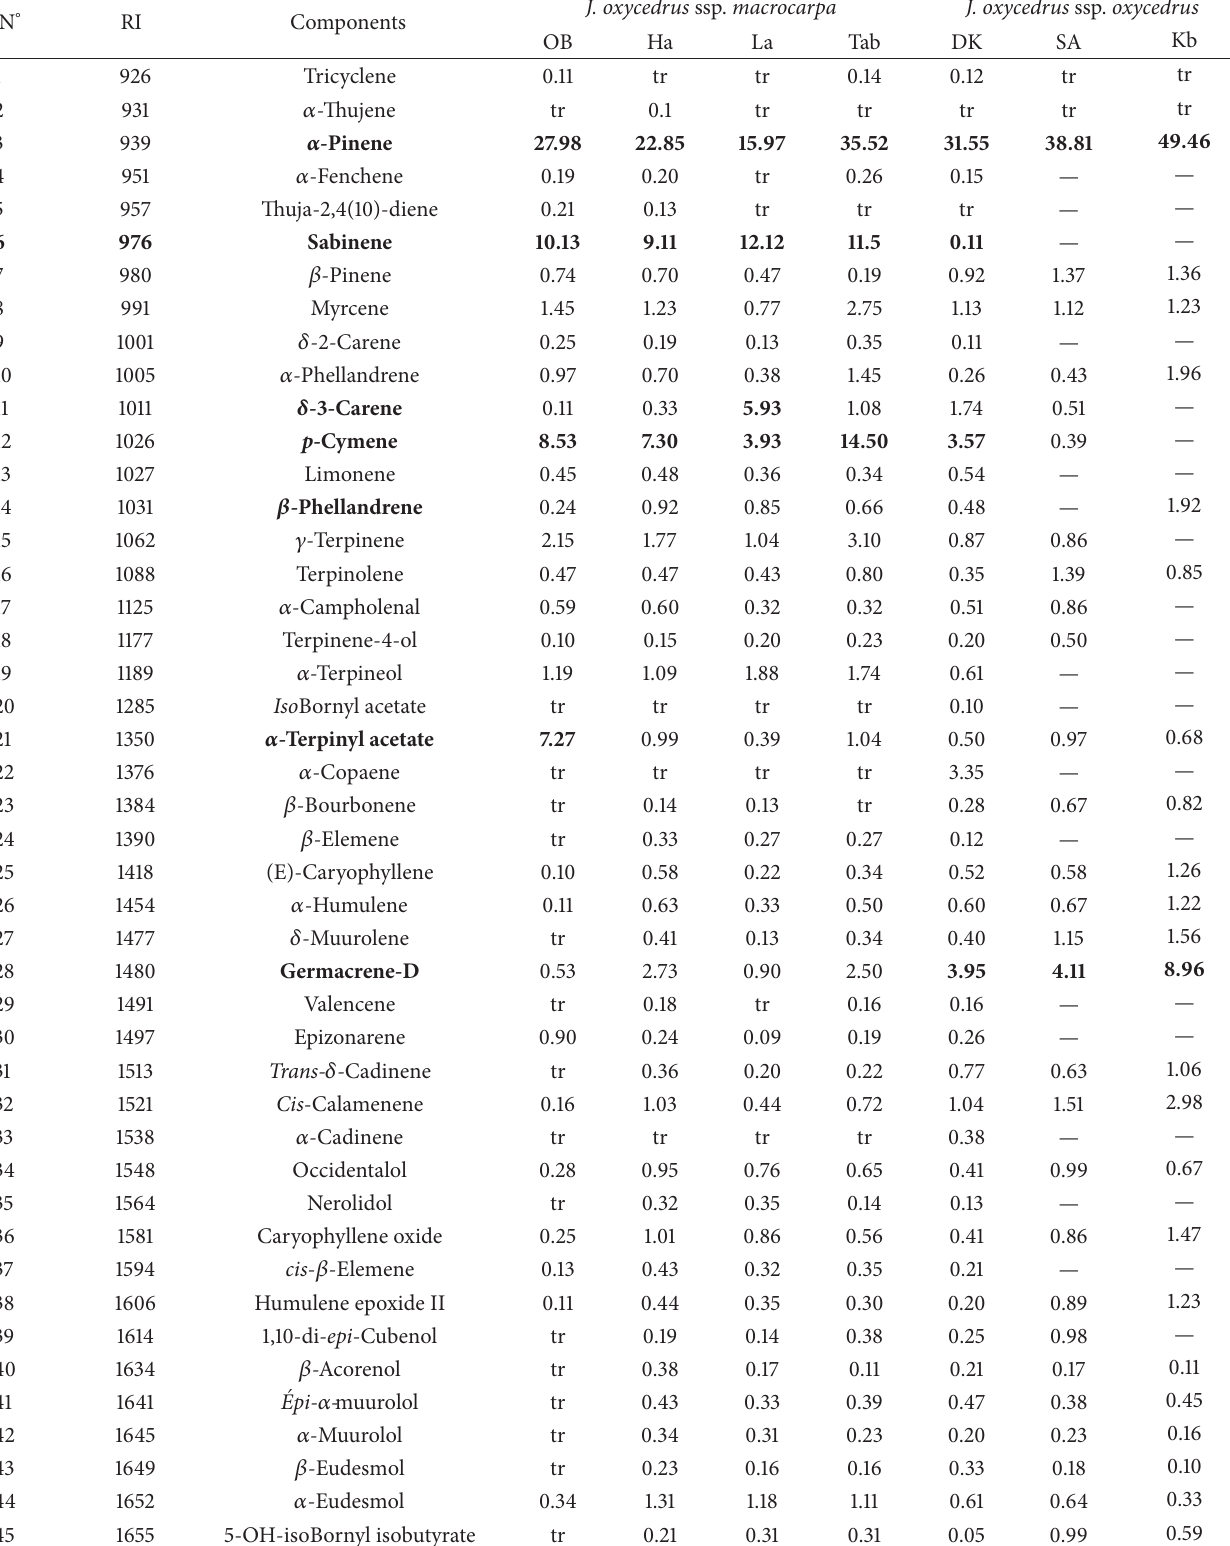
Table 2: Chemical composition of J. oxycedrus ssp . oxycedrus and J. oxycedrus ssp. macrocarpa leaf essential